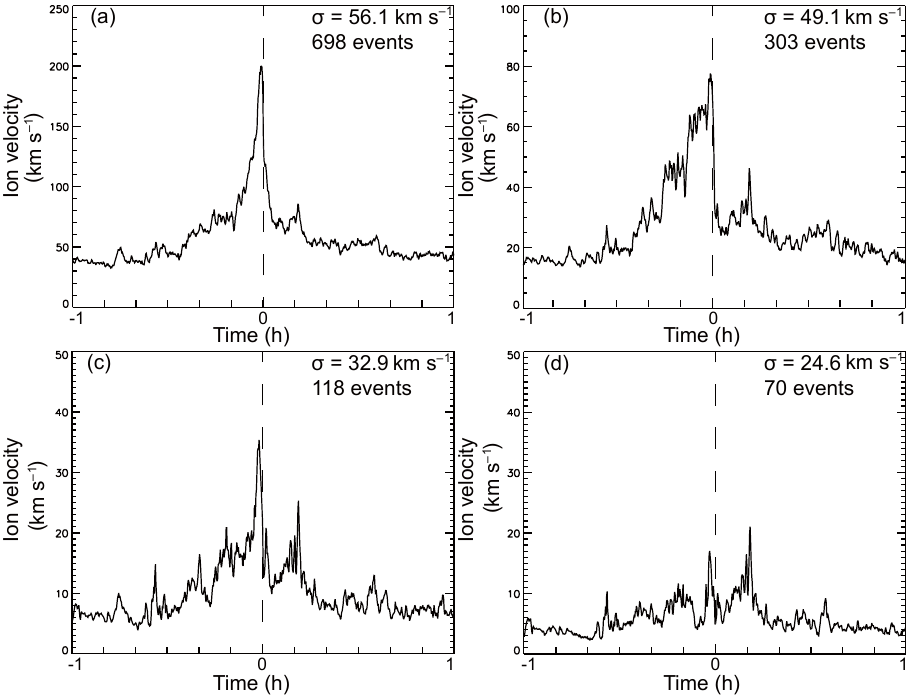
Figure 13. Superposed epoch analysis of ion velocity 1h before and after the time of selected severe magnetic fluctuation events. In panel (a) , we calculated the average of ion velocity at 0–1min before the event time and then selected those events with a 1min averaged ion velocity greater than the ion velocity at the event time. Panels (b) to (d) show the superposed epoch analyses of ion velocity 1h before and after the time of selected severe magnetic fluctuation events with similar methods by changing the time intervals of average value calculation into 10min before, 1min after, and 10min after the event